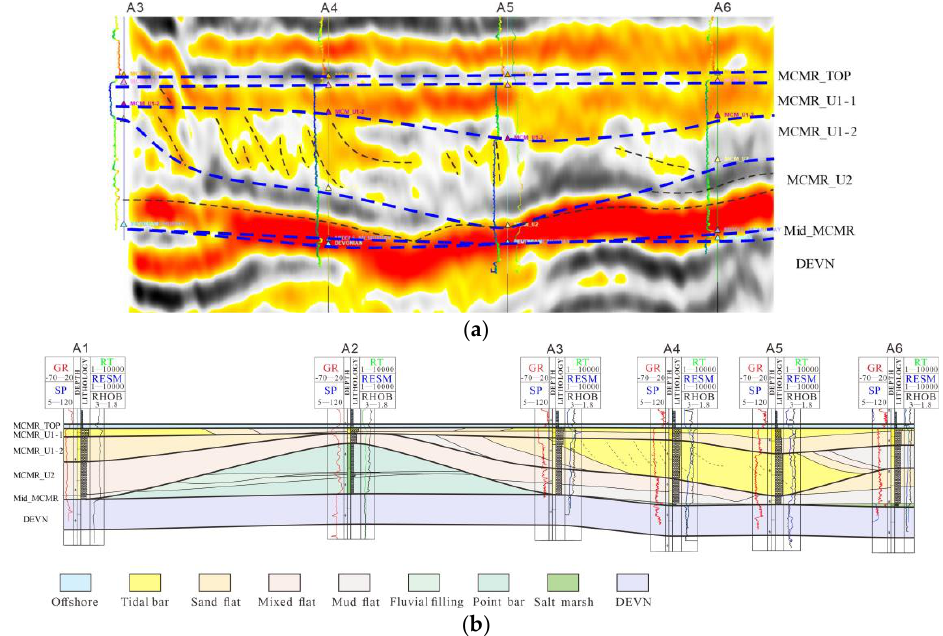
Figure 5. ( a ) Two-dimensional seismic section interpretation of cross-section 1. The GR curve is on the left, and the RESS curve is on the right. ( b ) Architectural elements analysis of cross-section 1. MCMR is an abbreviation for McMurray. (The section location is shown in Figure 4).